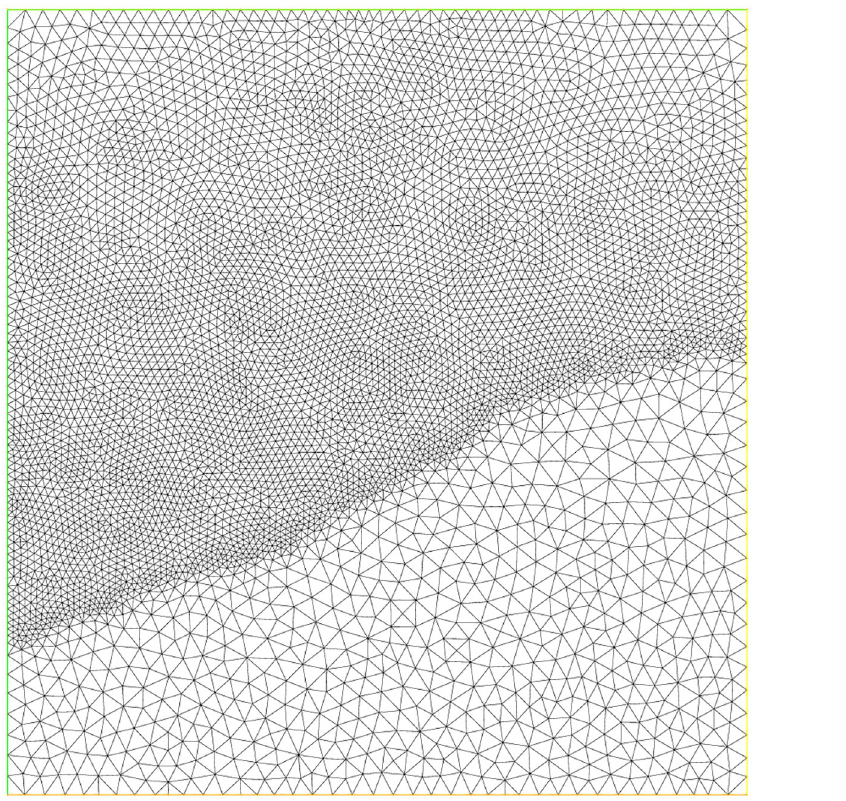
Fig 13. Adaptive mesh refinement with 19670 nodes for experiment 6.